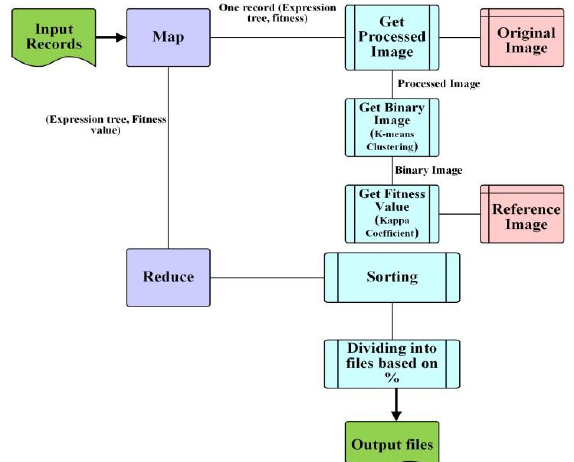
Figure 4. Main steps in the first MapReduce job used to create the first generation.